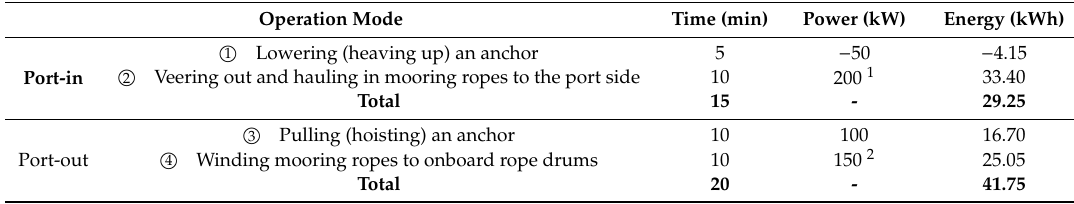
Table 4. Expected power demands for the port in / out mode.